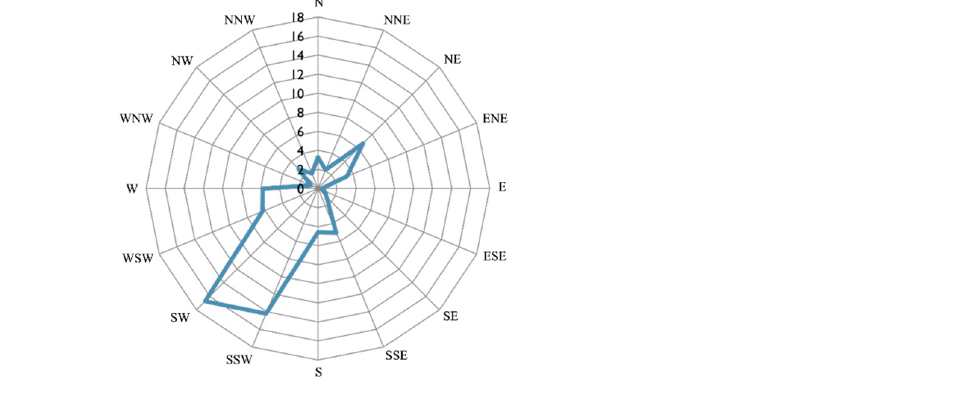
Figure 6. Wind rose characteristic of AZRF settlements in winter (according to RosHydroMet, the Russian meteorological service).